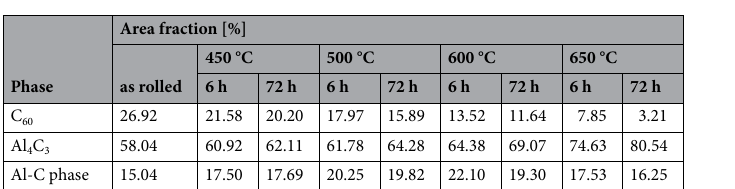
Figure 5. ( a ) XPS spectra (C1s) of Al/C60 nanocomposites after heat treatment at various temperatures for 6 and 72 h, and ( b ) the resulting variation of phase fraction.